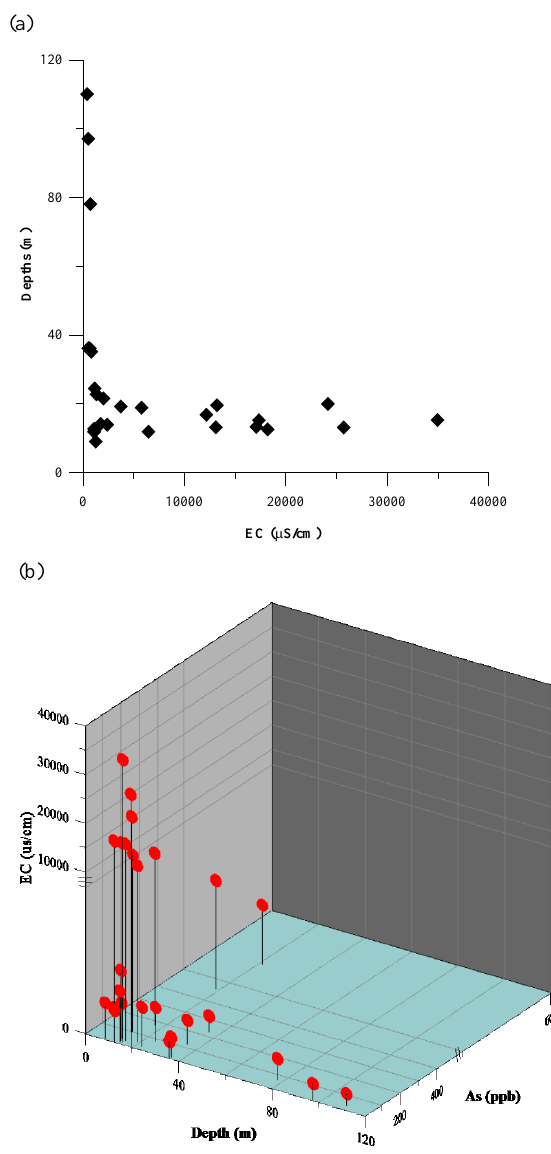
Fig. 3. (a) Scatter plot of EC and well depth of YL1-YL28. (b) Three dimensional plot of EC, As concentration and well depth of YL1-YL28.